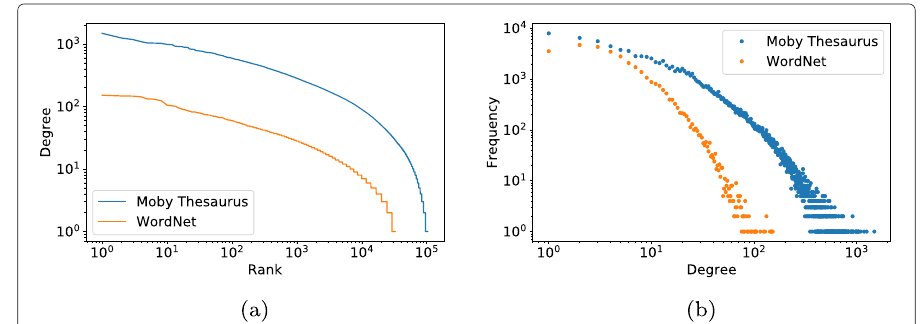
Fig. 1 Degree distributions of largest connected component in WordNet synonyms and Moby Thesaurus networks